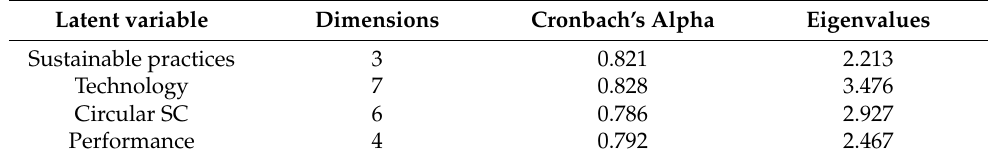
Table 3. Composite reliability